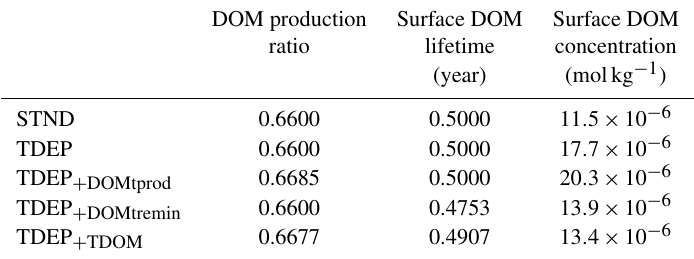
Table 5. Present (2010) DOM parameters.